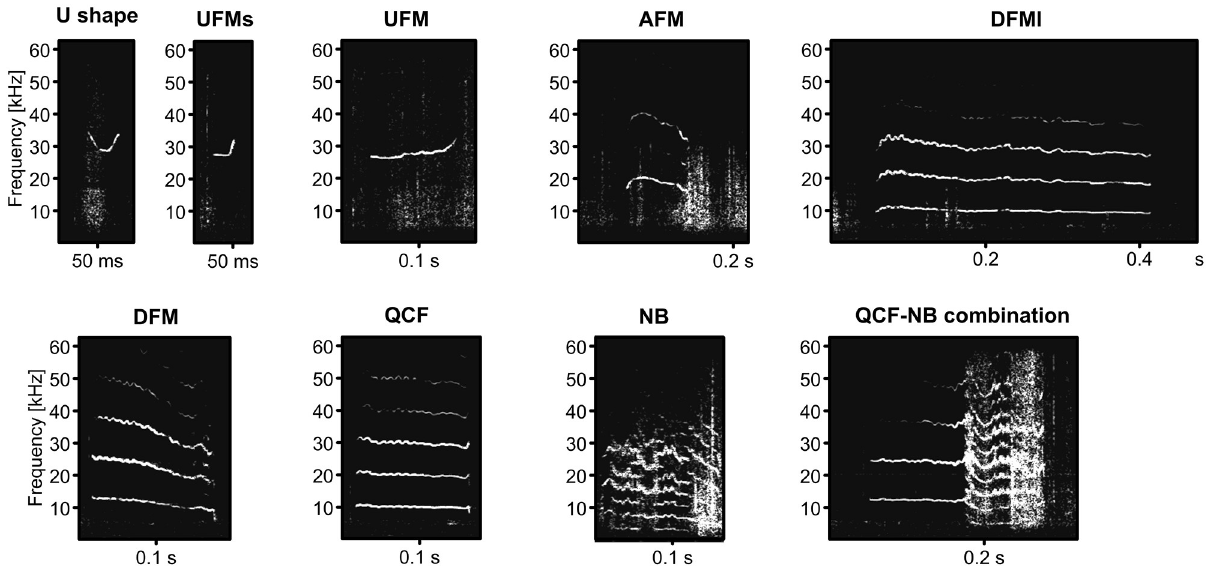
Fig 1. Representative spectrograms of nine call types of